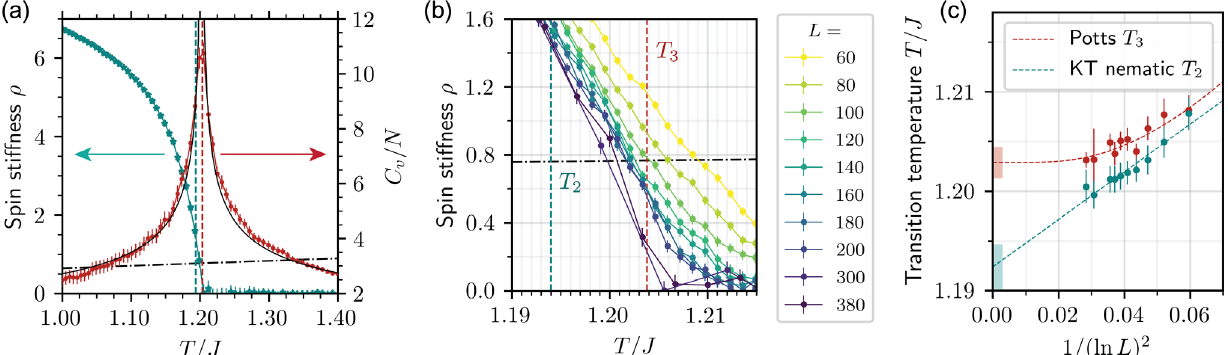
FIG. 6. (a) Spin stiffness ρ and specific heat per site c as a function of the temperature T=J at Δ ¼ 1 . 0 and for linear system size L ¼ 300 . Dashed vertical lines denote the asymptotic transition temperature T ≡ T ∞ Þ (blue) and T ≡ T ∞ Þ (red) from 2 2 ð 3 3 ð extrapolation to L → ∞ [see panel (c)]. The divergence of c at T 3 occurs close to the upturn of ρ at T 2 . The solid black line is a fit of c to t − α with α ¼ 1 = 3 , which allows the extraction of a Potts transition temperature T L Þ . The crossing of the dot-dashed black line 2 T= π 3 ð with ρ allows the KT transition temperature T 2 ð L Þ to be determined. (b) Spin stiffness as a function of the temperature T=J for Δ ¼ 1 . 0 and different system sizes between L ¼ 60 and L ¼ 380 . The crossing of ρ with the dot-dashed black line at T 2 ð L Þ shifts to lower temperatures as the system size L increases. Dashed vertical lines follow the same convention as in panel (a). (c) Evolution of Potts T L Þ and nematic-KT T L Þ transition temperatures with system size L . Extrapolation to infinite system size is obtained by best fits to 3 ð 2 ð T L Þ ¼ T ∞ Þ þ a= ð ln L Þ 2 and T ∞ Þ ¼ T L Þ þ a 0 L − 1 = ν with Potts exponent ν ¼ 5 = 6 (cyan and red dashed lines). We find 2 ð 2 ð 3 ð 3 ð T ∞ Þ ¼ 1 . 194 (cid:3) 0 . 002 and T ∞ Þ ¼ 1 . 2022 (cid:3) 0 . 0005 , and nonuniversal constants a ¼ 0 . 21 (cid:3) 0 . 05 , a 0 ¼ 1 . 00 (cid:3) 0 . 16 . Shaded boxes 2 ð 3 ð denote the best estimate for thermodynamic transition temperatures with a confidence of 1 standard deviation. This demonstrates that the Potts transition at T 3 occurs above the nematic-KT transition at T 2 , a conclusion also reached in the absence of the corrections to scaling shown in Fig.